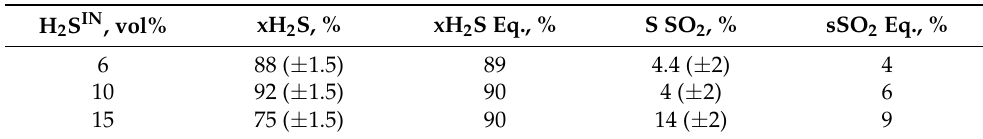
Table 2. Equilibrium and experimental data by varying the H 2 S inlet concentration (T = 327 °C, contact time = 0.6 s).